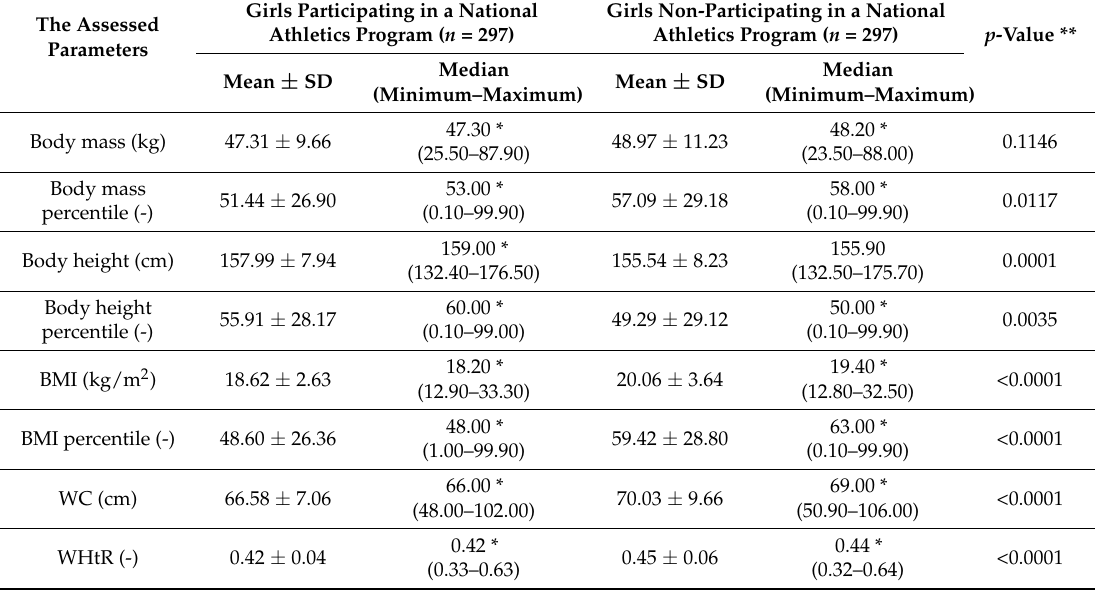
Table 3. The basic anthropometric characteristics of group of girls participating in a national athletics program and pair-matched control group of